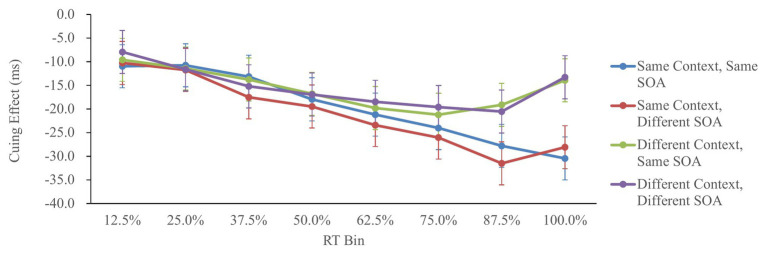
Cuing effect in Experiment 2, as a function of context, SOA, and RT bin. Cuing effect = invalid RT − valid RT. Error bars represent the 95% confidence interval, based on the method of Jarmasz and Hollands (2009).